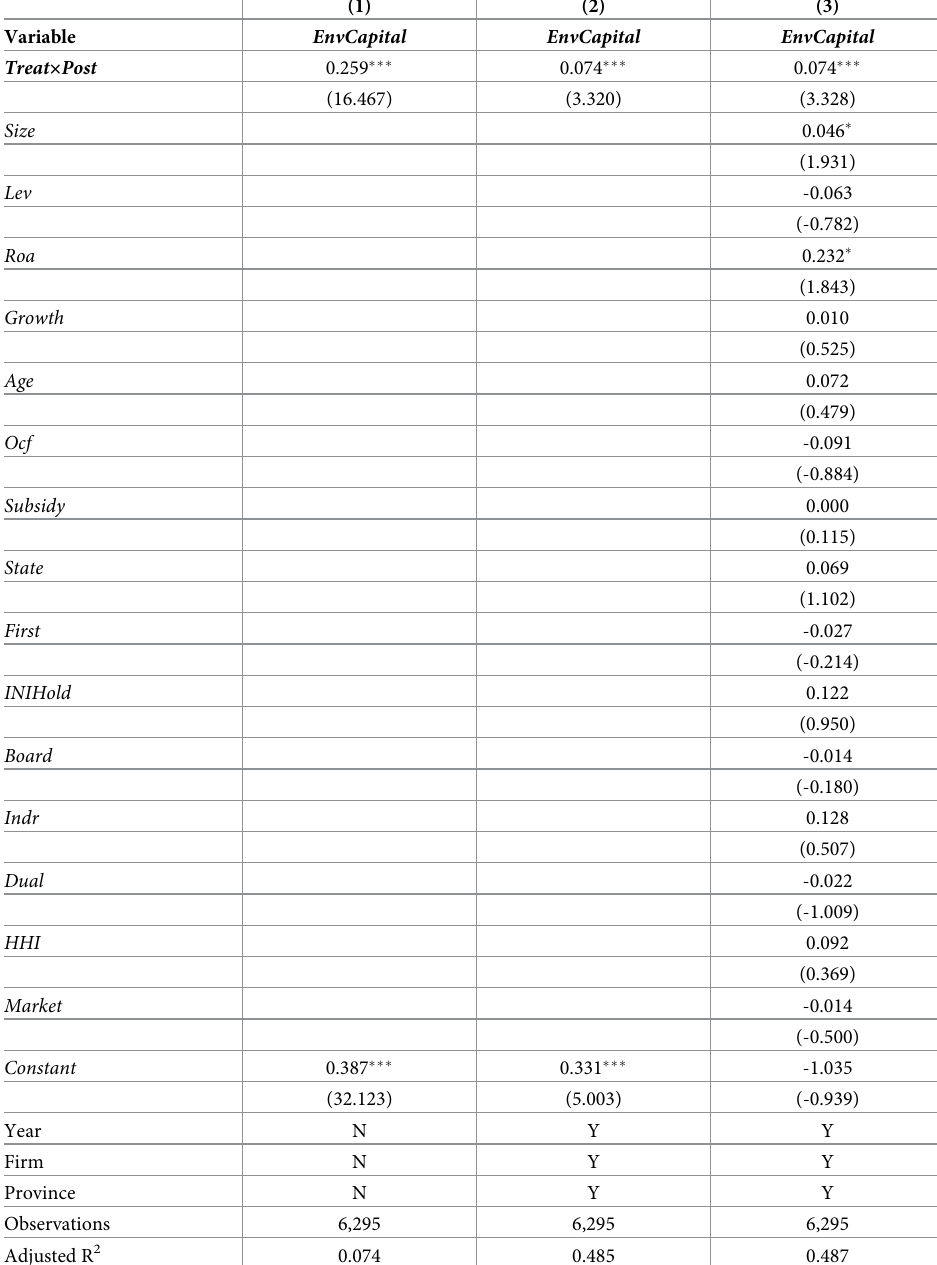
Table 4. The new environmental protection law and the capitalization of corporate environmental protection